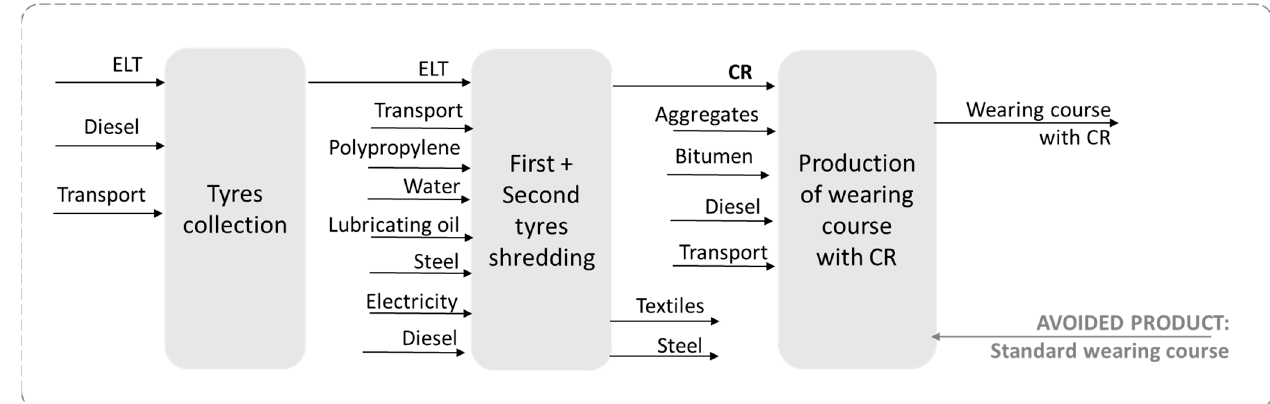
Figure 2. System boundaries of the recycling scenario.